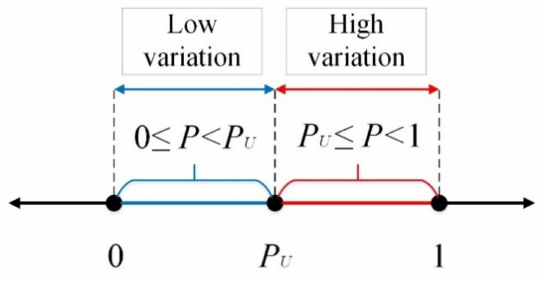
Figure 3. Variation